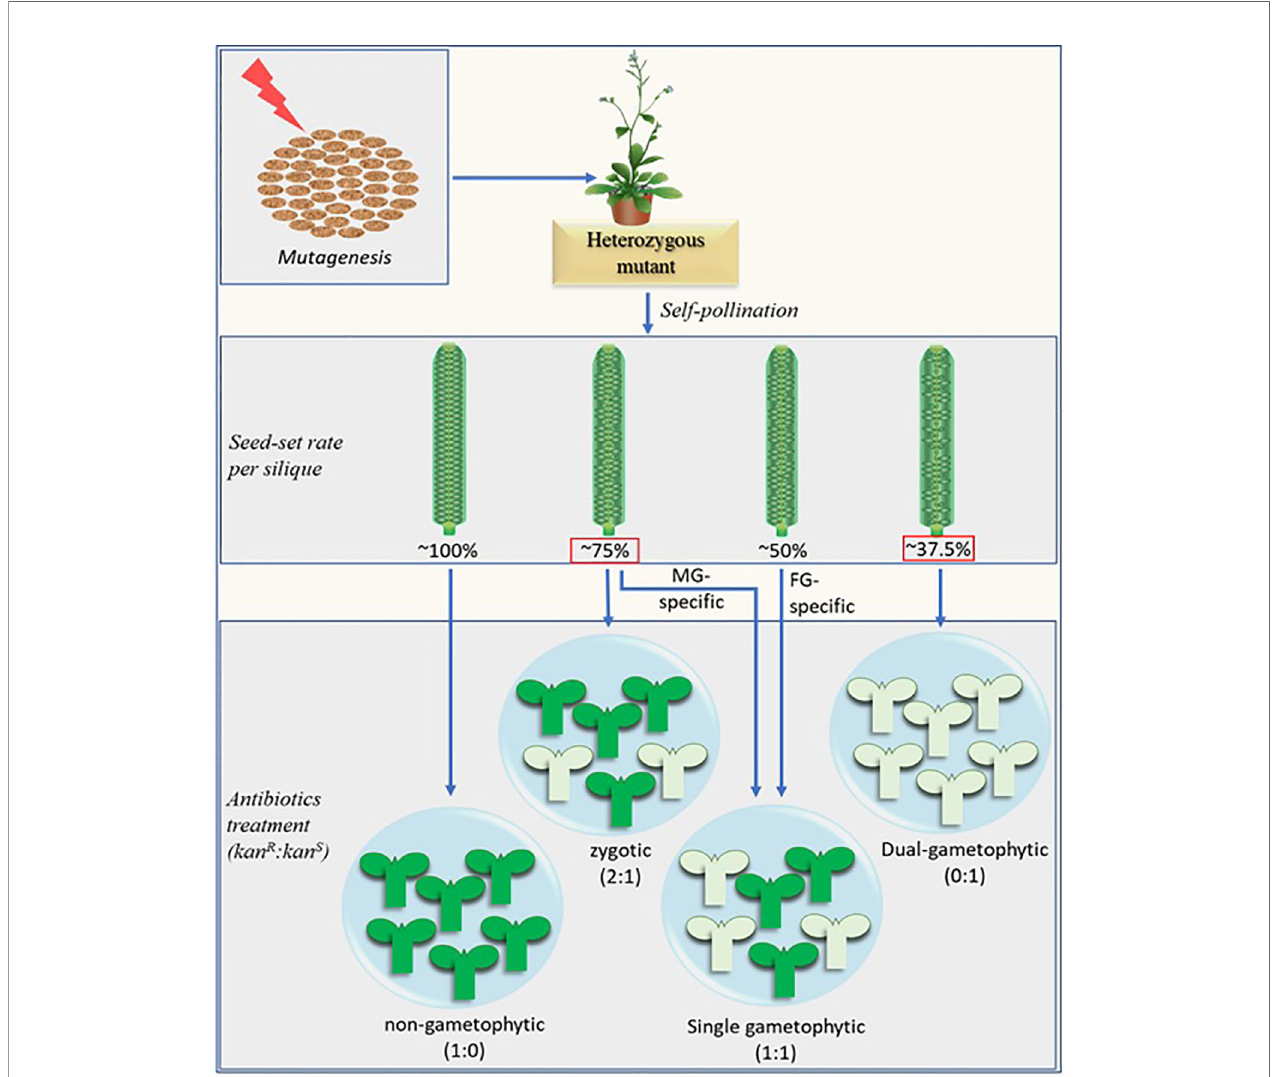
FIGURE 1 | Schematic representation of the modi fi ed screening method combined with the potential distortion in seed-set rate brought about by the fertilization recovery system (Beale et al., 2012; Kasahara et al., 2012). The numerical fi gures represent the theoretically possible maximum values. The fully penetrant dual- gametophytic fertilization defective mutants (with defect in both MG and FG) may show the lowest seed-set (37.5%). None of their progenies will carry the selection marker. The MG-speci fi c and zygotic mutants, on the other hand, may show similar seed set rates (~75%), but their progenies reveal different selection marker segregation ratio (1:1 and 2:1 respectively). The seed-set rates in red squares are derived by considering the fertilization recovery system which is crucial for MG- speci fi c and dual-gametophytic mutant identi fi cation via novel screening method. The MG-speci fi c mutants mentioned here are equivalent to sperm cell-speci fi c mutants. Aborted ovules are depicted by the smaller oval structures in the siliques, marker-positive and marker-negative progenies are represented by the green and pale-green seedling structures respectively. Kanamycin (kan) is shown as a representative selection